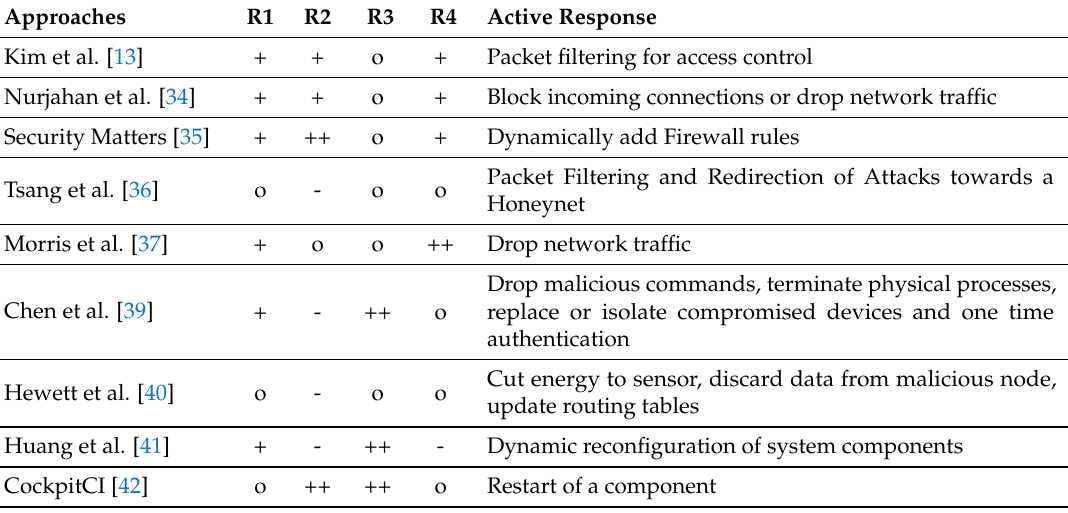
Table 1. Overview of related approaches for reactive responses in Industrial Automation Systems (IAS) and ratings using Requirements for reactive protection in